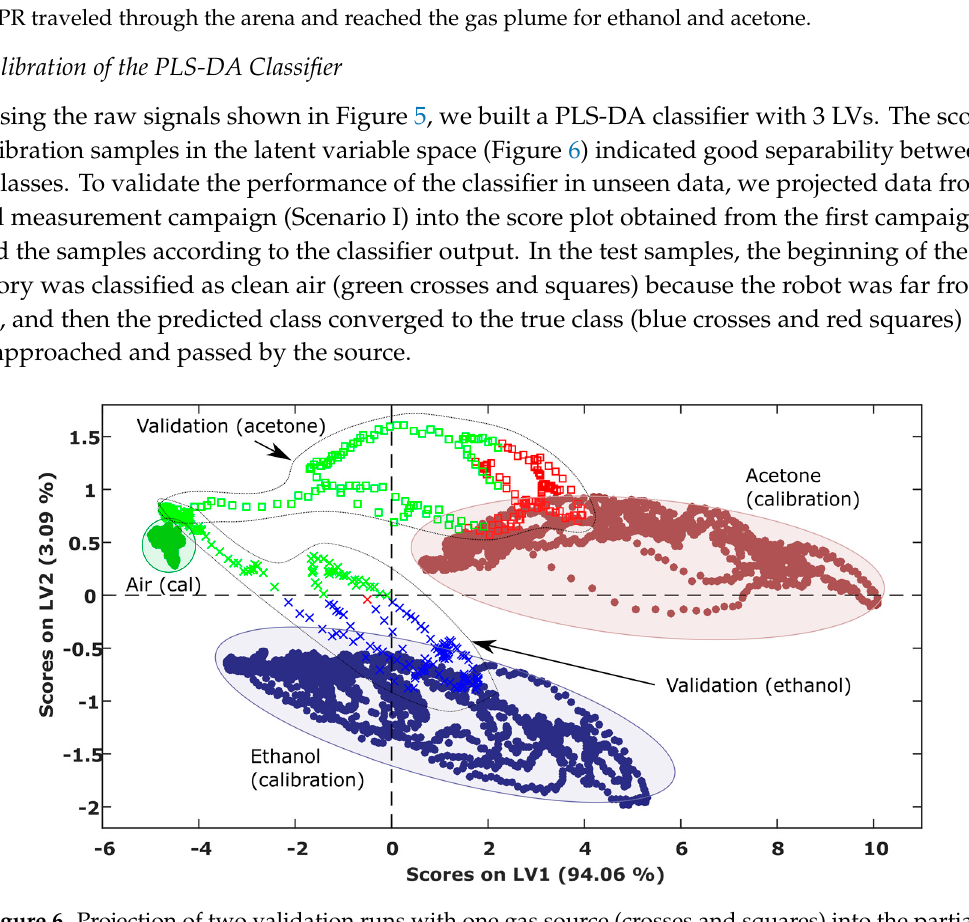
Figure 6. Projection of two validation runs with one gas source (crosses and squares) into the partial least squares discriminant analysis (PLS-DA) score plot of calibration data (filled circles). The validation data are colored according to the label given by the classifier.